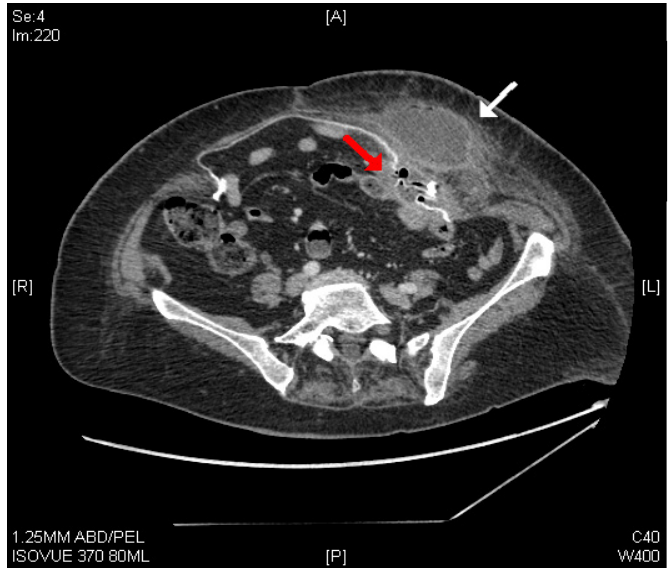
Image 2. Computed tomography showing extraperitoneal (white arrow) and intraperitoneal (red arrow) abscesses associated with mesh and small